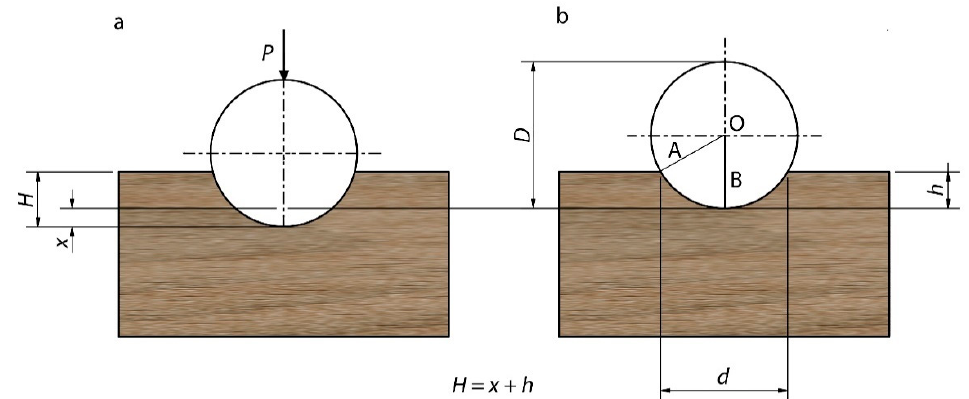
Figure 4. Geometrical relationships when measuring hardness using the Brinell method: ( a ) ball under load, ( b ) ball after load is removed ( P —measuring load, D —diameter of the ball, d —diameter of the indentation, H —total indentation, h —plastic indentation (permanent), x —elastic indentation (temporary)).